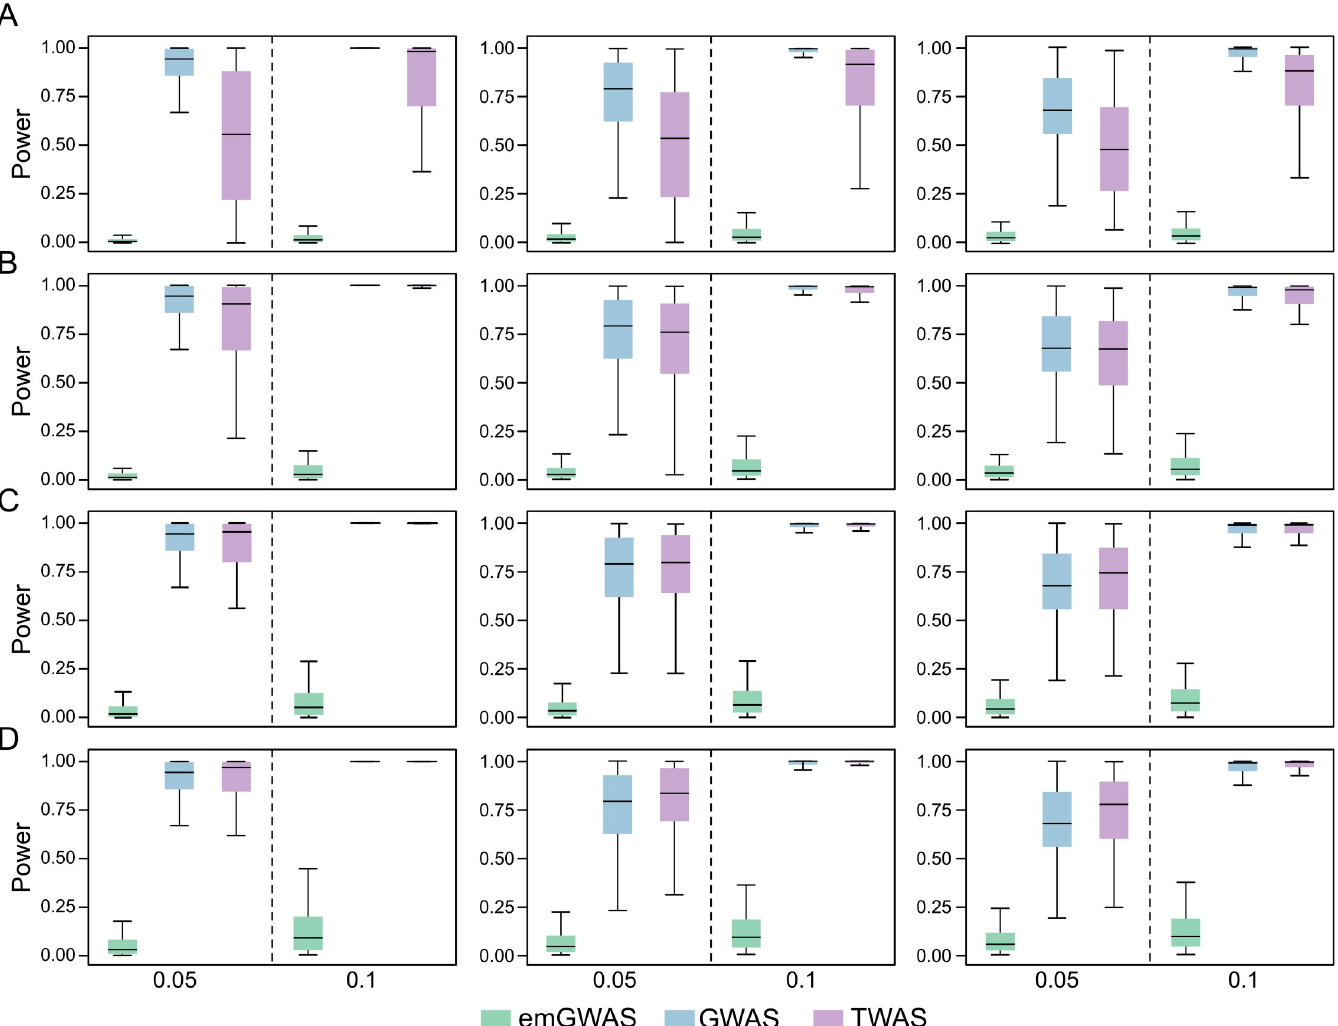
Fig 5. Pleiotropy scenario when expression heritability is low and trait heritability is high. The PVX is 0.05 and 0.1 in the two columns as indicated by the X-axis labels. The numbers of genes contributing to phenotype for the left, middle and right panels are 4, 9, and 13 respectively. The expression heritability levels in (A), (B), (C) and (D) are 0.025, 0.04, 0.06, and 0.08 respectively. The number of causal variants per gene is randomly sampled from the interval